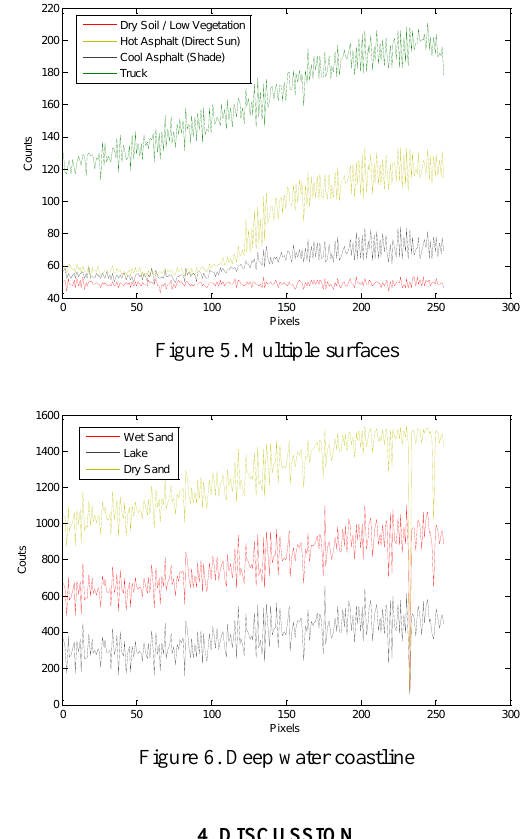
Figure 6. Deep water